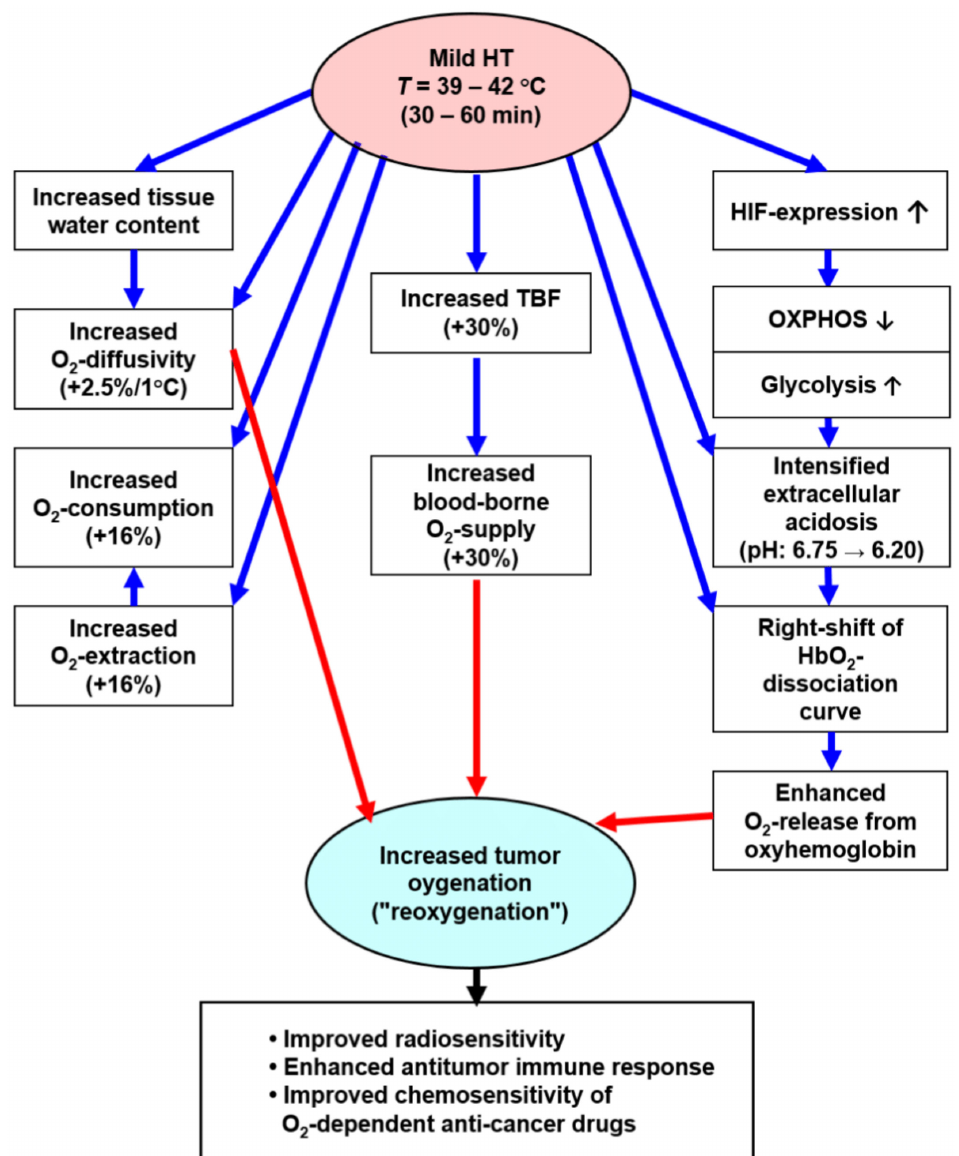
Figure 4. Mechanisms responsible for the improvement of the O 2 status upon localized mHT through enhancement of the O 2 availability (central pathway), increased O 2 diffusivity due to hyperhydration of tumor tissues and direct mHT-impact (left pathway), and intensified tumor acidosis leading to a right-shift of the HbO 2 -dissociation curve, thus facilitating the O 2 release from the blood into the tissue (right pathway). Most probably, the mHT-induced increment in the O 2 consumption is compensated by a comparable increase in the O 2 -extraction (left